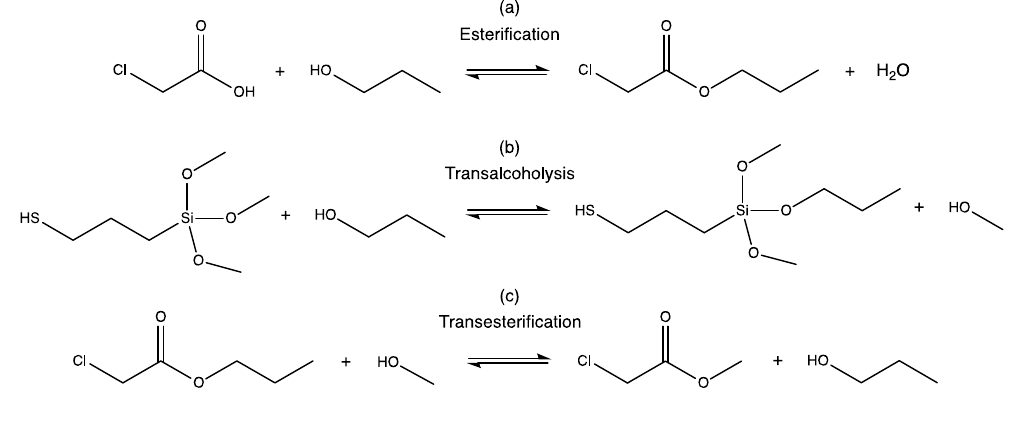
Figure 1. Reactions occurring in the ISWP reaction mixture (adapted with permission from [15] Borovin et al., 2016 © Wiley-VCH).